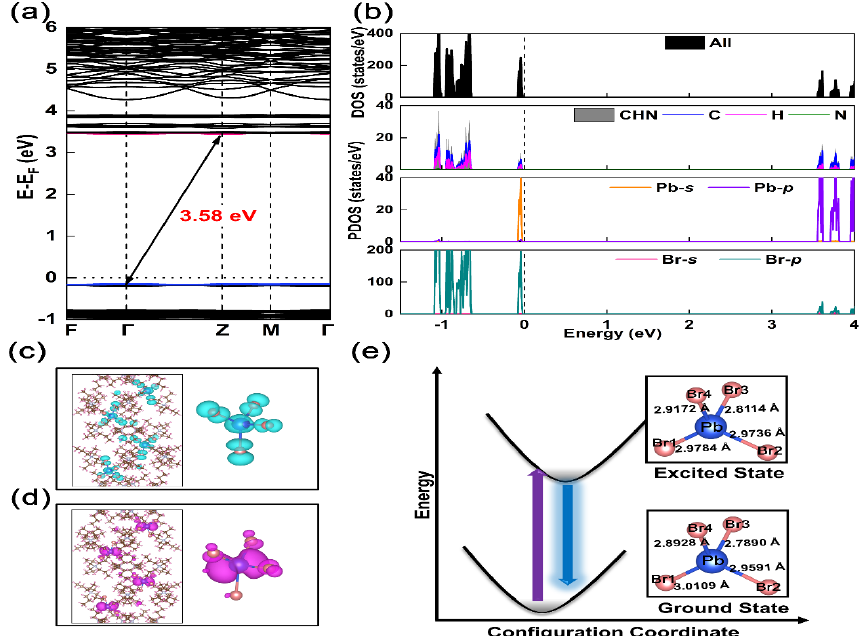
Figure 3. The electronic structure properties for ( a ) band structures and ( b ) DOS of (TPA) 2 PbBr 4 . The charge distribution density of LUMO ( c ) and HOMO ( d ) in (TPA) 2 PbBr 4 . ( e ) Schematic diagrams of the excited and ground states for [PbBr 4 ] 2− structure with the specific bond lengths of Pb-Br, respectively.